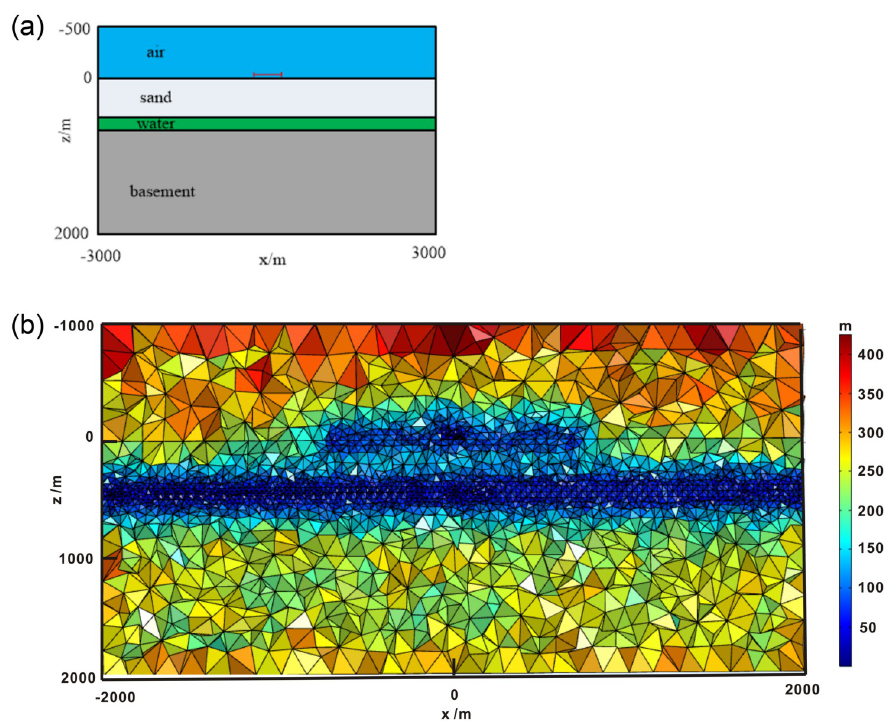
Fig 9. (A) Schematic diagram of a 1D layered model. (B) Vertical section of the mesh at y = 0 m.